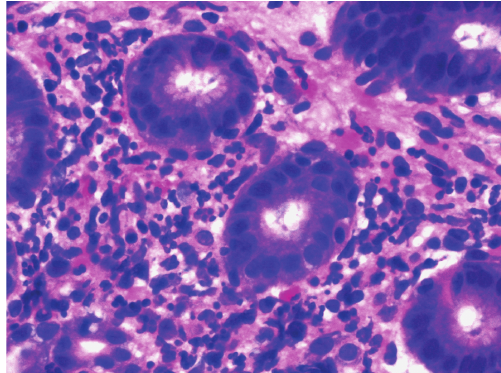
Figure 5: Histopathology of HSP involvement in small bowel showing neutrophilic and eosinophilic infiltrates which are seen with karyorrhectic debris.